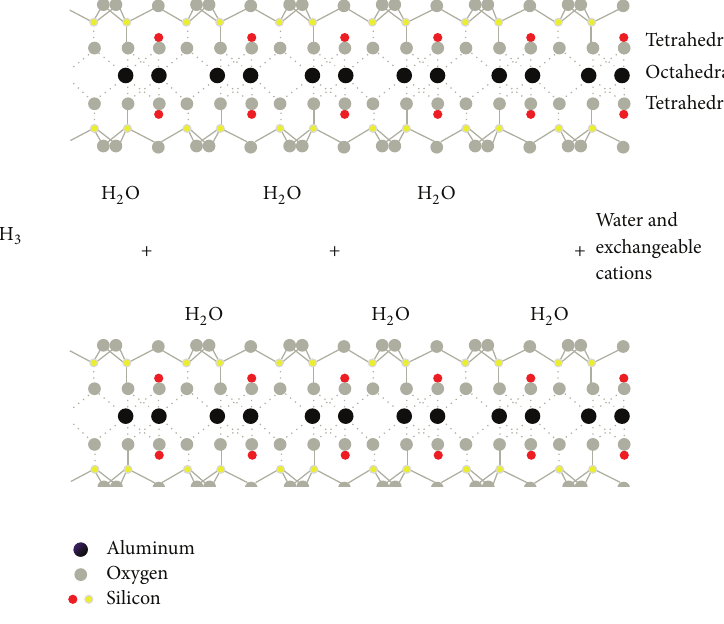
Figure 1: Structure of MMT clay and CPC.